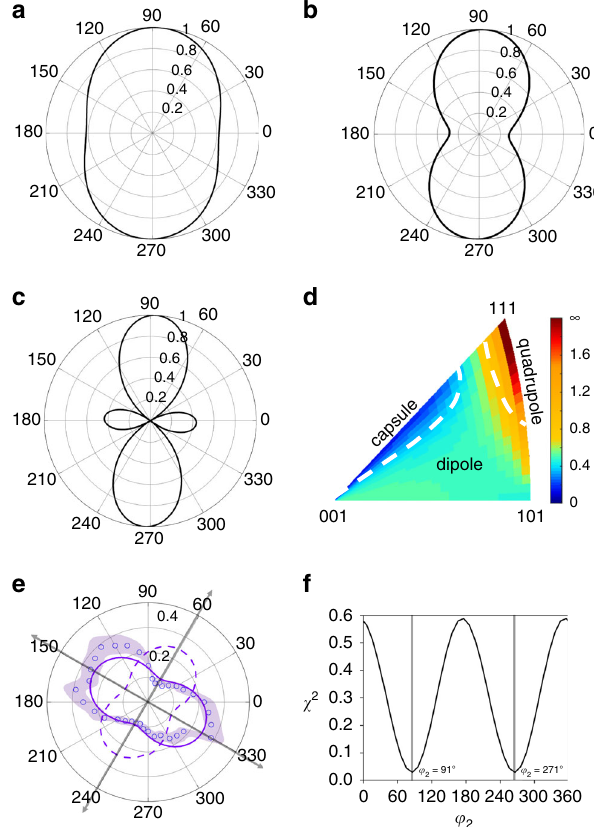
Fig. 4 Impact of grain orientation on the FTA amplitude pro fi le. a capsule shape ( N » M ); b dipole shape ( N > M ); c quadrupole shape ( N < M ); d ratios of M and N and corresponding shapes projected onto a color-coded inverse pole fi gure; e comparing two pro fi les that have the same values of φ Φ but different values for φ 1 and 2 (solid and dashed line). The solid line corresponds to the best fi t to the experimental data (circles); f the sum of the square of the differences between experiment and theory versus φ 2